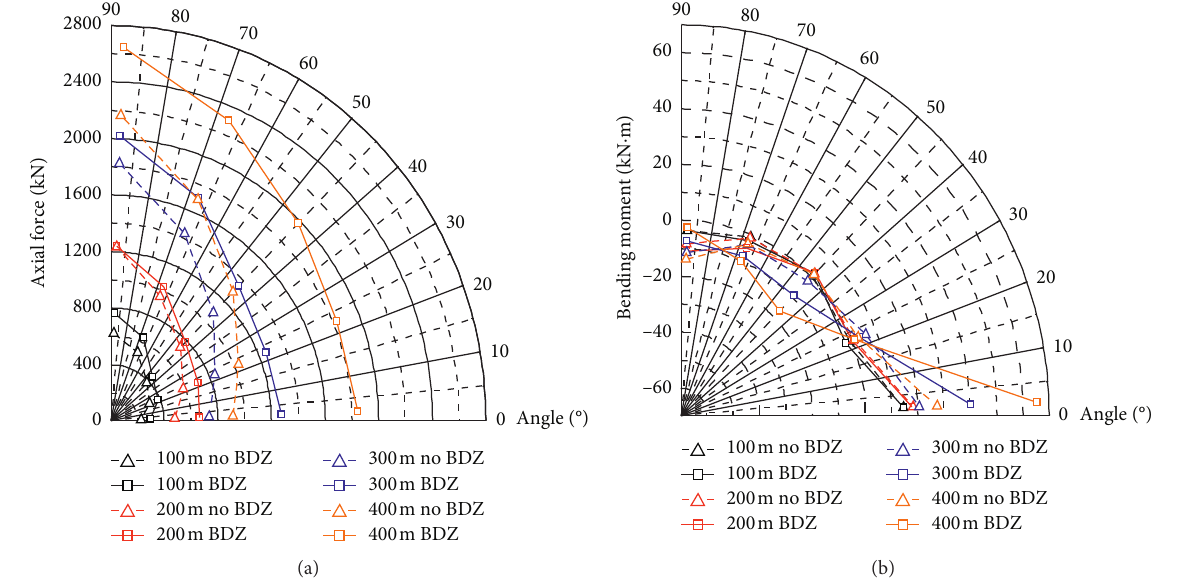
Figure 15: Modeled distributions of the (a) axial force in kN and (b) bending moment in kN · m.